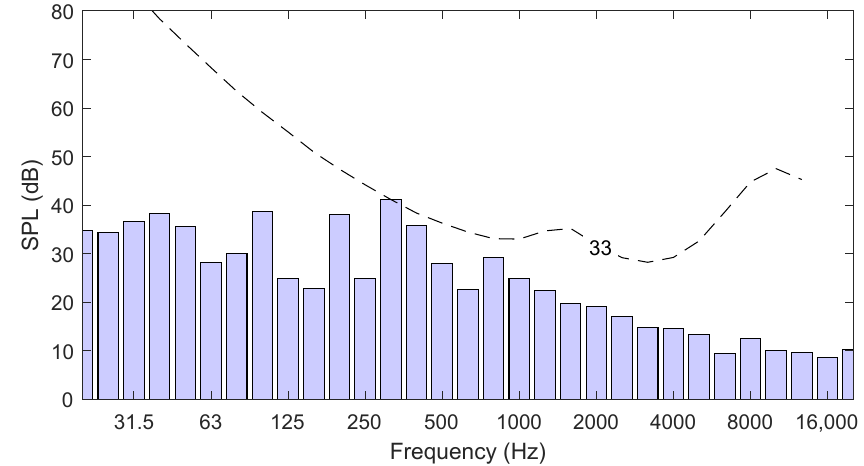
Figure 12. Spectrum of the minimum values for noise measured with the sources turned on at the façade of the receiver building (first floor). Dashed line: 33 phon equal loudness